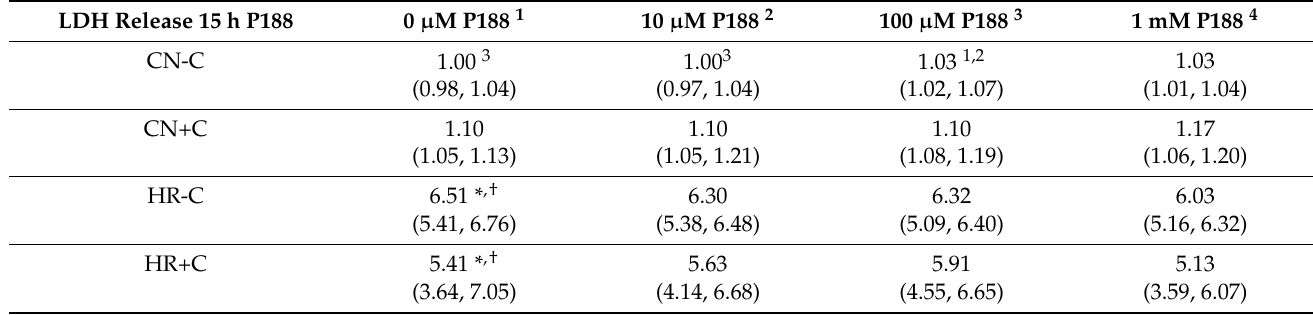
Table A6. Cytotoxicity/membrane damage after 15 h injury and treatment with 0 µ M, 10 µ M, 100 µ M, and 1 mM of P188. Data from Figure A2 visualized as table (median, 25th, 75th percentile); p < 0.05; n = 4 experiments/group. Significances between different concentrations of P188 are displayed as superscripted numbers, significances between 0 µ M P188 CN-C, CN+C, HR-C, and HR+C are represented by symbols (* vs. CN-C 0 µ M P188, † vs. CN+C 0 µ M P188). Abbreviations: C, compression; CN, control/normoxia; h, hours; HR, hypoxia/reoxygenation; mM, millimolar; µ M, micromolar; P188, Poloxamer